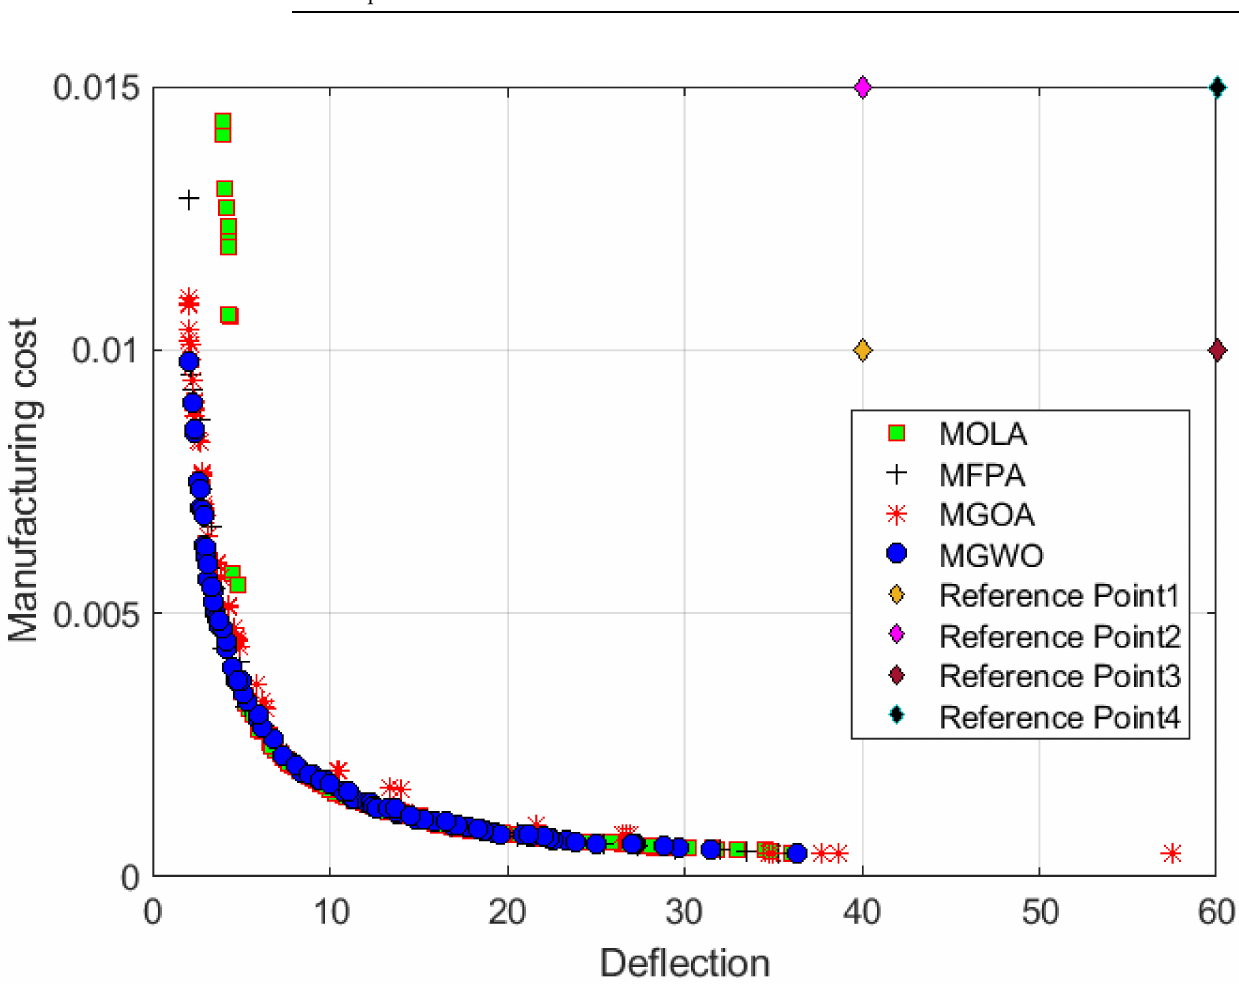
Figure 17. Obtained Pareto fronts of the developed MGWO, MFPA, MOLA, and MGOA for WBD under third